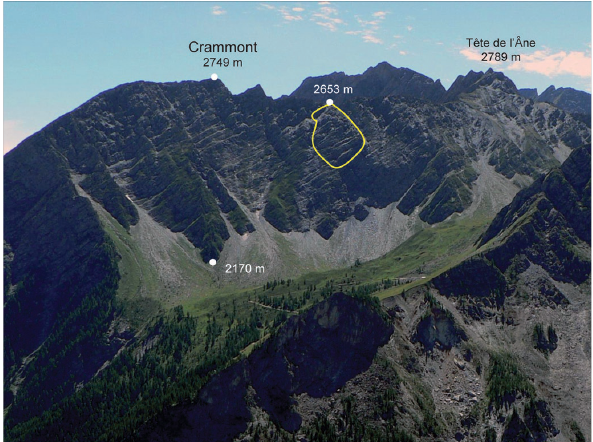
Fig. 3. View of the Crammont north side (August 2008). Area that eventually collapsed is delimited in